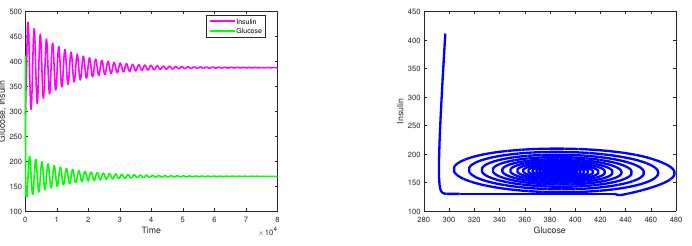
Figure 14. Glucose-insulin dynamics: dynamics and phase plain for τ ∗